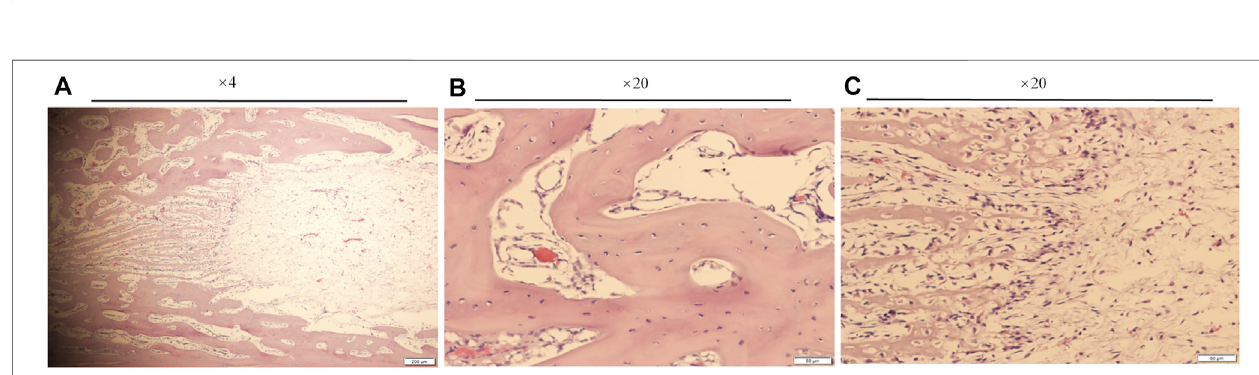
Frontiers in Bioengineering and Biotechnology |